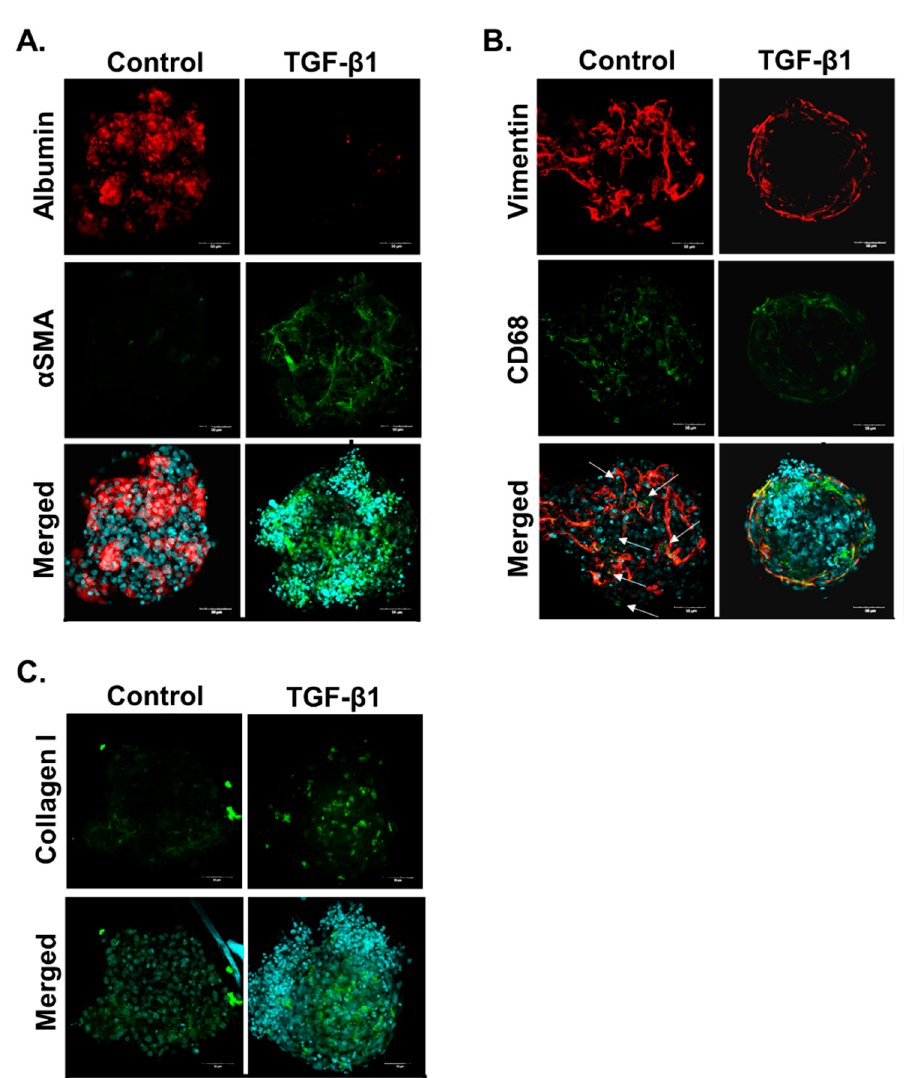
Figure 2. TGF- β 1 induces fibrosis in human liver MTs. MTs were left untreated or exposed to 1 ng/mL TGF- β 1 for 10 days which was refreshed every 2–3 days. The MTs were fixed and stained to demonstrate localization of the three cell types: HepaRG cells stain positive for albumin; hTERT- HSC stain positive for α SMA and vimentin; and THP-1 stain positive for CD68 and vimentin. HSC activation and ECM deposition were shown through increased α SMA and collagen I staining, respectively. Images are shown as a maximum intensity projection including the merged image with DAPI for each staining combination: albumin and α SMA ( A ), vimentin and CD68 ( B ) and collagen ( C ). Arrows identify THP-1 as these cells are positive for both CD68 and vimentin ( B ).